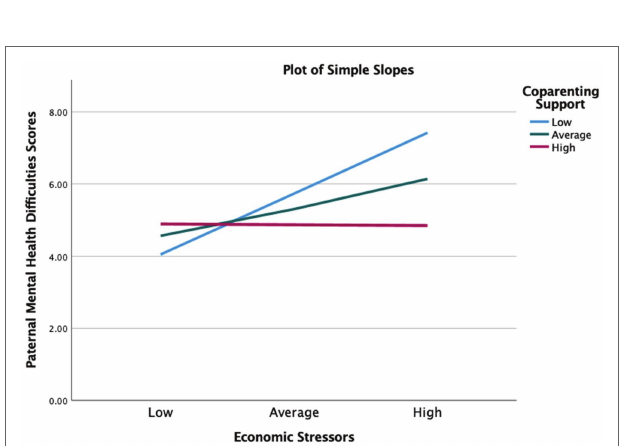
FIGURE 4 | Coparenting support moderating the effect of economic stressors on paternal mental health. High = 1 standard deviation above the sample mean, average = sample mean, and low = 1 standard deviation below the sample